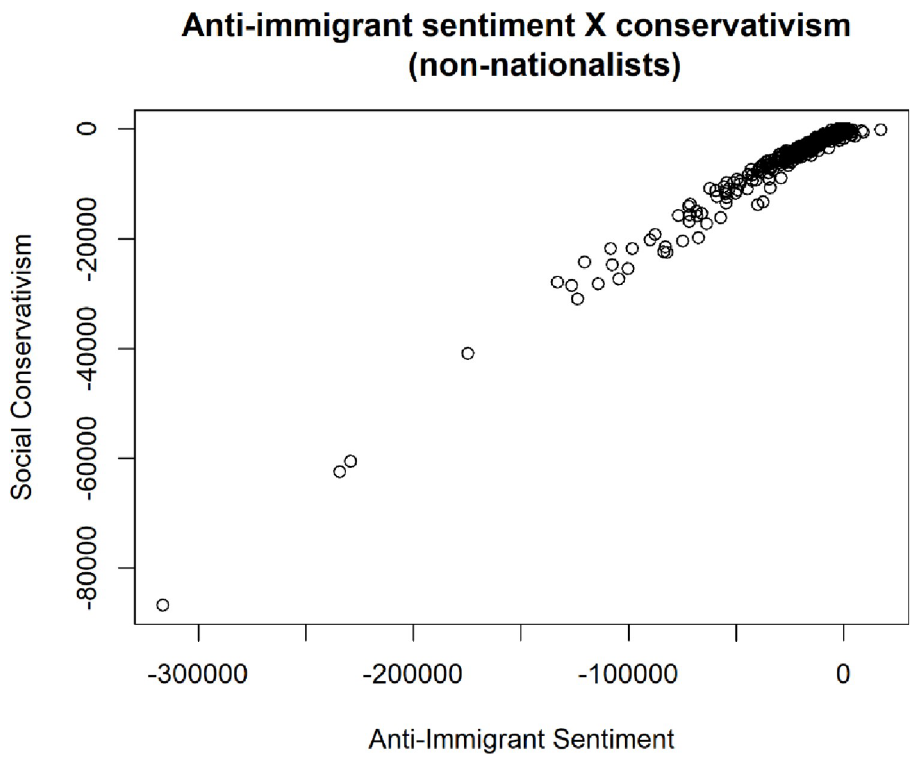
Fig 17. Cluster plot of relationship between liberal (left-wing) social values and anti-immigrant sentiment.